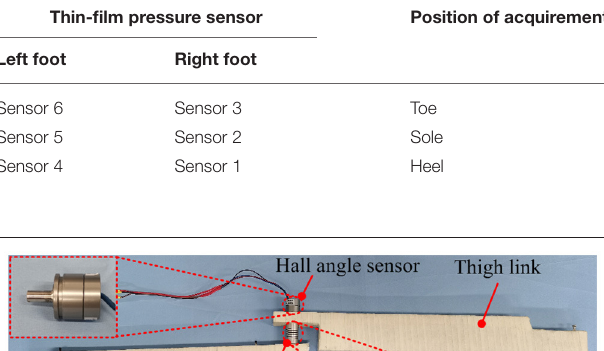
TABLE 1 | Corresponding acquisition position of a thin-film pressure sensor.